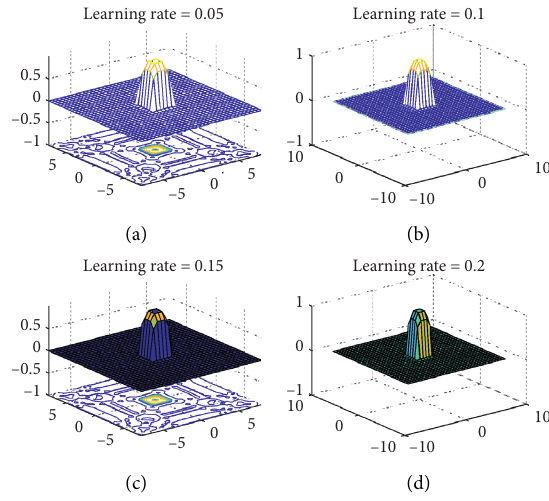
Figure 9: Comparison of MAE at different learning rates.